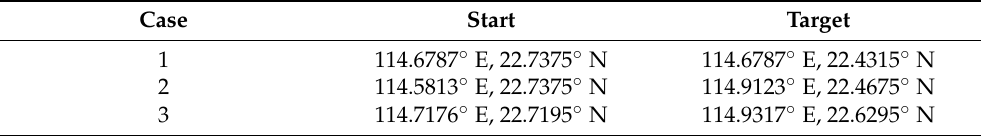
Table 2. The coordinates of starting and target points in the three cases.